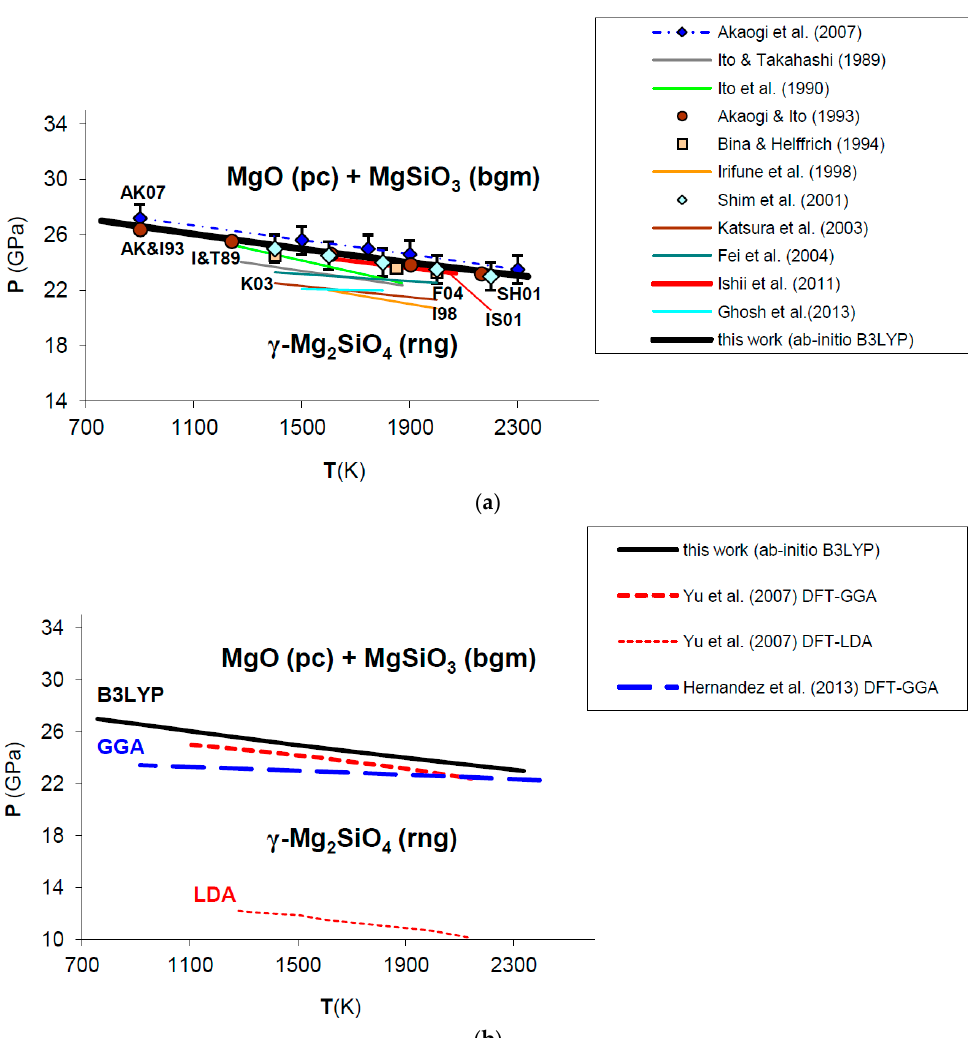
Figure 11. Ab initio B3LYP phase boundary of post-spinel transformation (in bold) as compared to: ( a ) experimental results (multi-anvil press, laser-heated diamond-anvil cell) [124,127–130,132,133] and calculations based on calorimetric measurements [121,125,126,131]; ( b ) other ab initio LDA [137] and GGA [138] calculations. Abbreviations for minerals are: rng = ringwoodite ( γ -Mg 2 SiO 4 ); pc = periclase (MgO); bgm = bridgmanite (MgSiO 3 ).